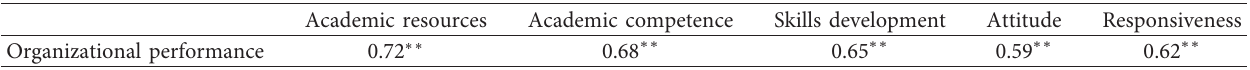
Table 4: Correlation between academic service quality dimensions and organizational